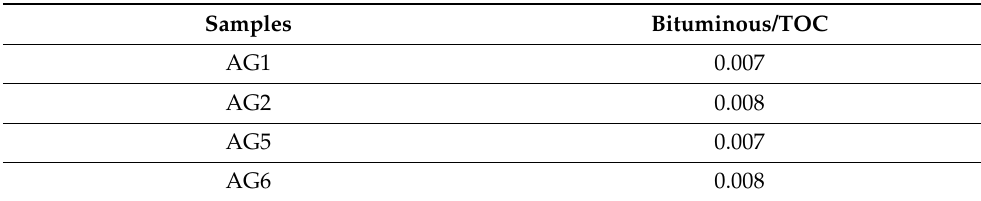
Table 3. The ratio of Bitumen/TOC.